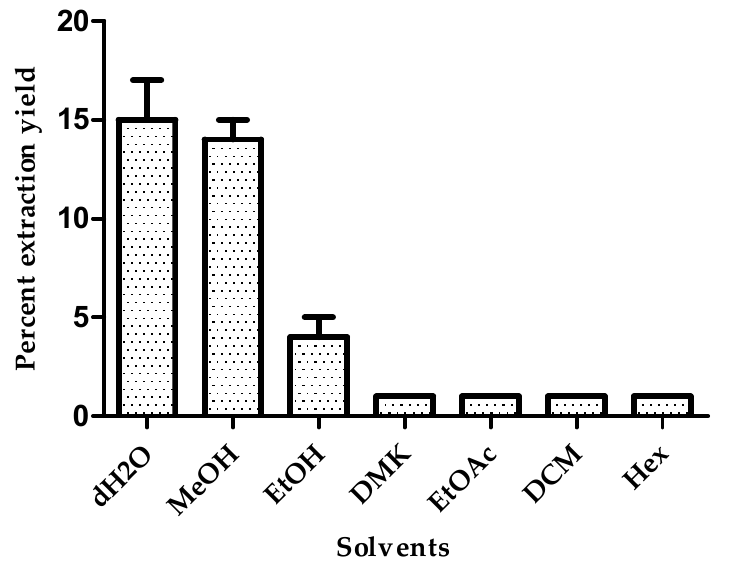
Figure 1. Percent extraction yield. Preparations of B. x buttiana with seven different extraction solvents at 100% at 26 °C for 24 h were prepared as described in the Materials and Methods section. Each bar corresponds to the results (mean ± standard deviation (SD)) from three different preparations.